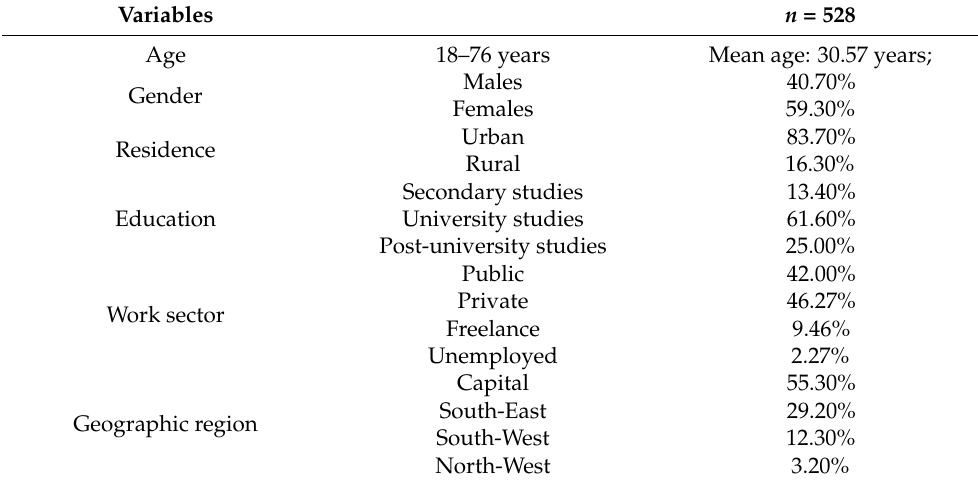
Table 1. The sociodemographic characteristics of the analysed sample. Variables n = 528 Age 18–76 years Mean age: 30.57